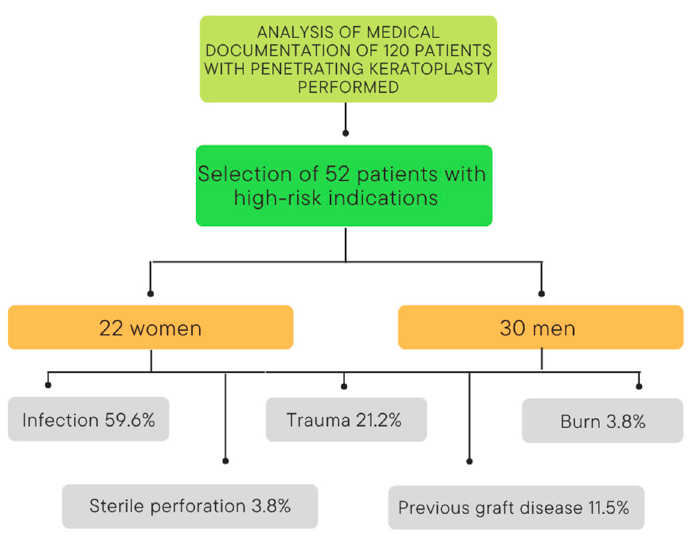
Figure 2. Structure of the study group, according to sex and the etiology of corneal blindness.